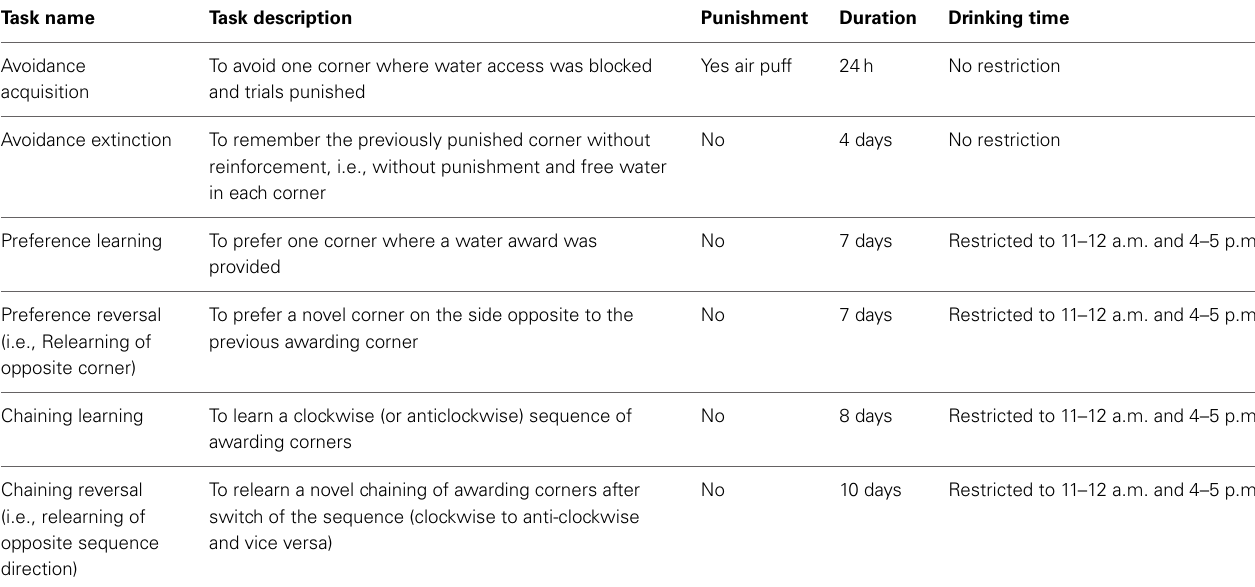
Table 1 | Behavioral